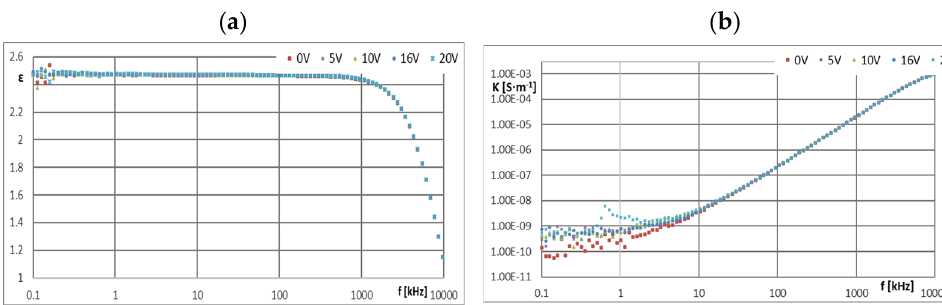
( b ) Figure 7. Characteristics: ( a ) ε = f( f ) and ( b ) κ = f( f ) for GP1 at different values of U. ( a )